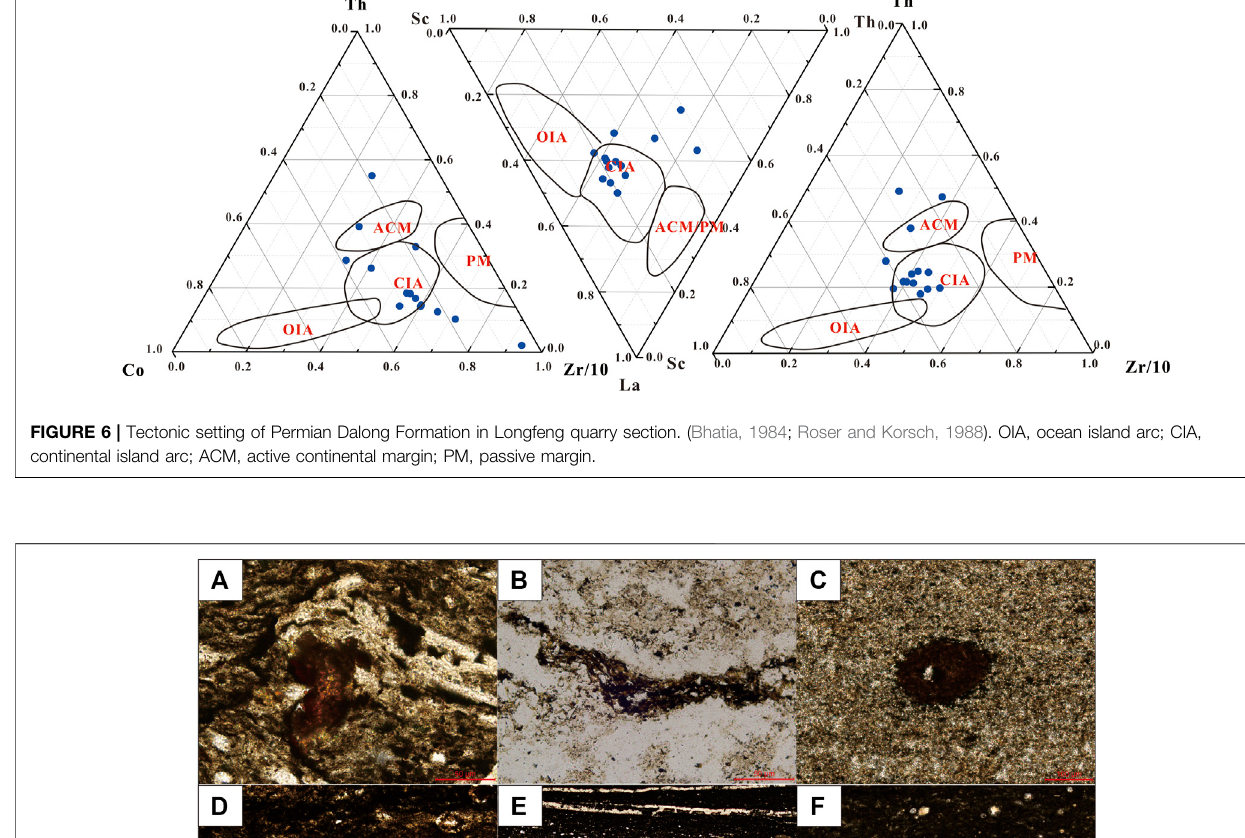
Frontiers in Earth Science |